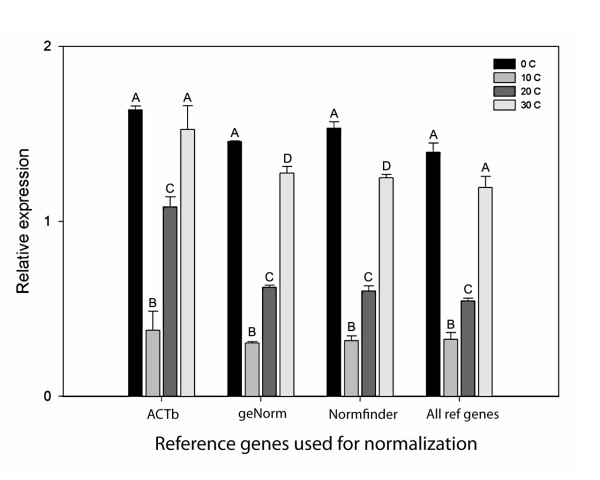
HSP70 expression of Folsomia candida in the temperature treatment normalized with four different sets of reference genes. HSP70 expression between different pools of F. candida exposed to different temperatures, normalized with four different sets of reference genes (ACTb: only beta-actin; the best set selected by geNorm (SDHA &ETIF); the best set selected by Normfinder (ETIF, SDHA, EF1a &UBC) and all available reference genes). One-way ANOVA analysis with Bonferroni post-hoc test revealed significant differences (P < 0.05) between 0, 10 and 20°C and between 10, 20 and 30°C in all normalization sets. Significant differences between 0 and 30°C were only detected when normalized with the optimum sets of reference genes selected by either geNorm or Normfinder. The letters above the bars indicate significant differences where different letters between bars represent a significant difference within 1 normalization set.